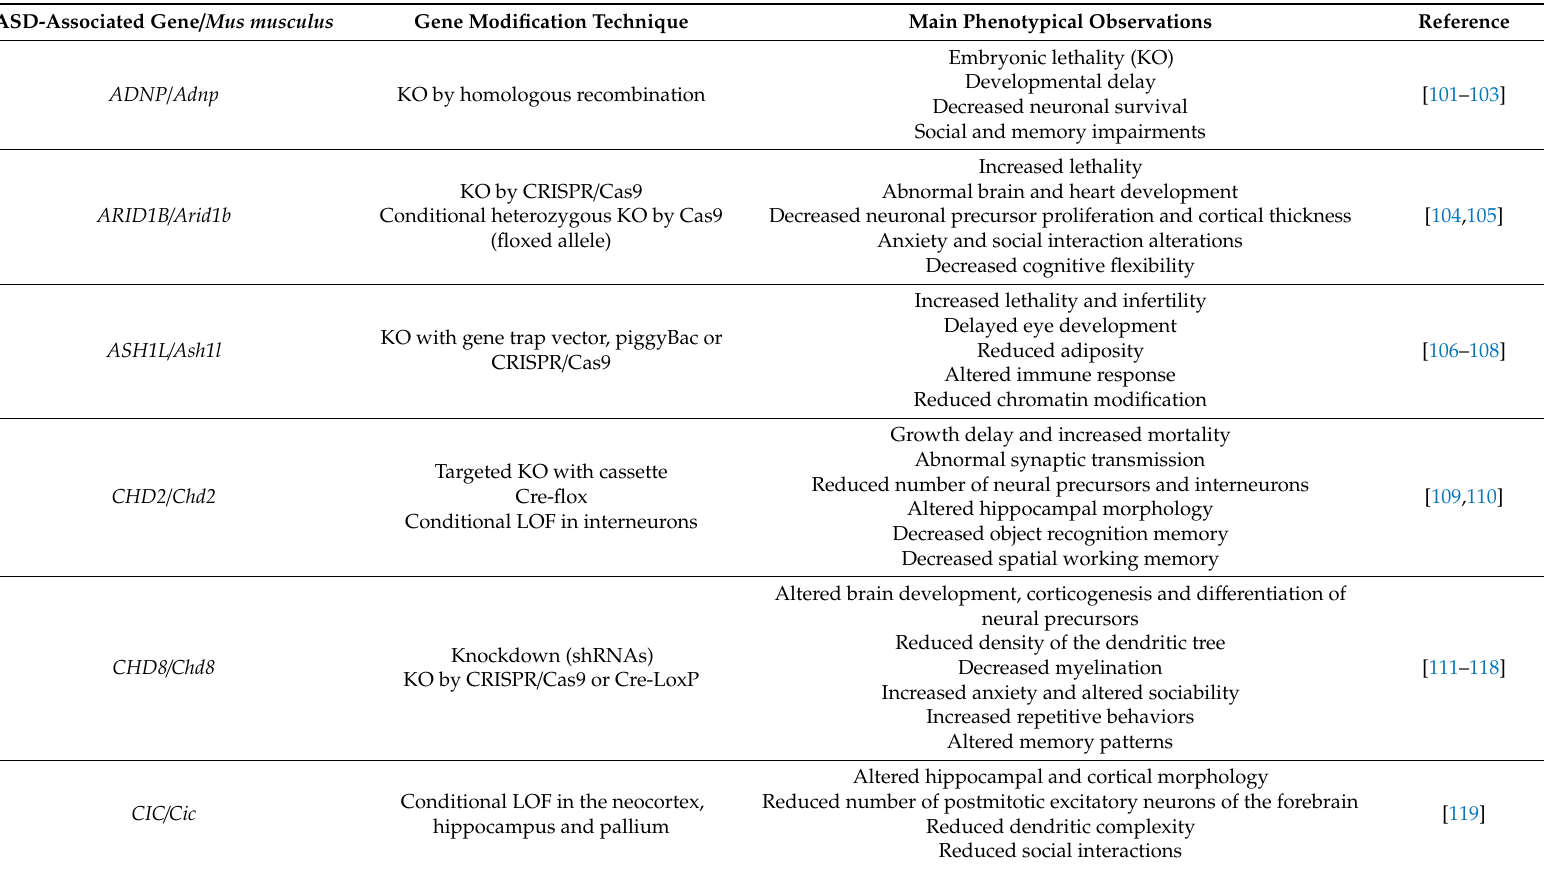
Table 5. Phenotype observed in Mus musculus models of ASD-associated genes. The table includes the some of the developed models to study the function and implication in ASD of genes classified with score 1 (high confidence) or gene score 2 (strong candidate) in the SFARI Gene database [20,21]. In the cases in which several models have been developed, the phenotype column only includes their common characteristics; LOF—loss of function, SVZ—subventricular zone, MGE—medial ganglionic eminence,